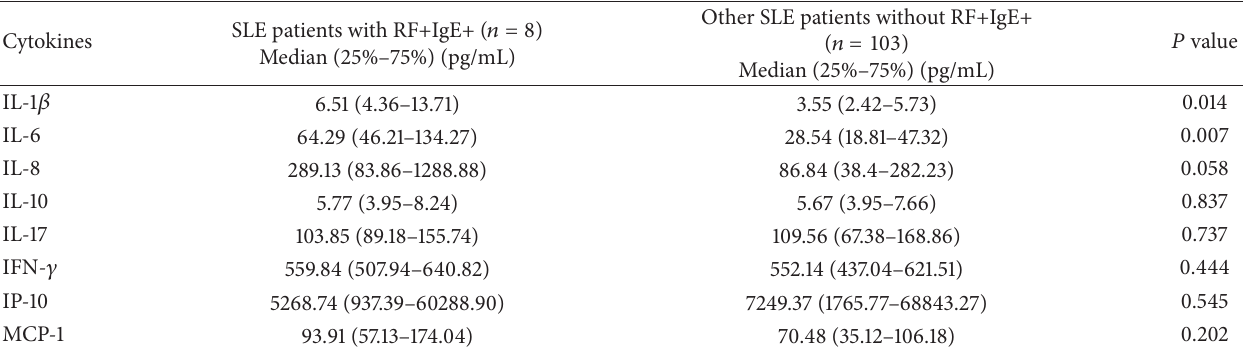
Table 7: Serum cytokine levels of all SLE patients with RF+IgE+ and without RF+IgE+. SLE patients with RF+IgE+ ( 𝑛 = 8 Cytokines